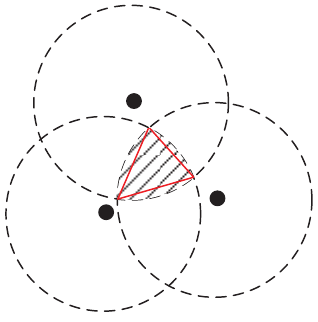
Figure 2. An example for the feasible